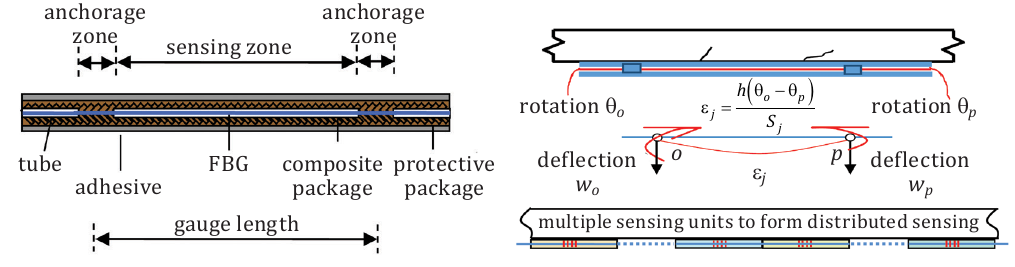
a) the internal structure b) the measuring Figure 1. The long-gauge Fiber Bragg Grating sensor